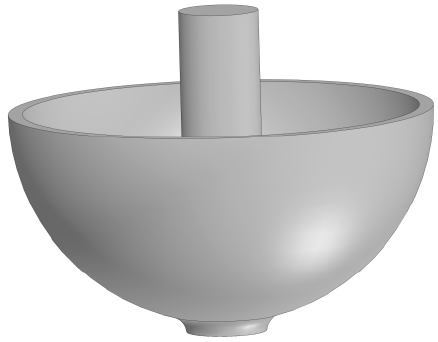
Figure 1. Structure of a hemispherical shell resonator.